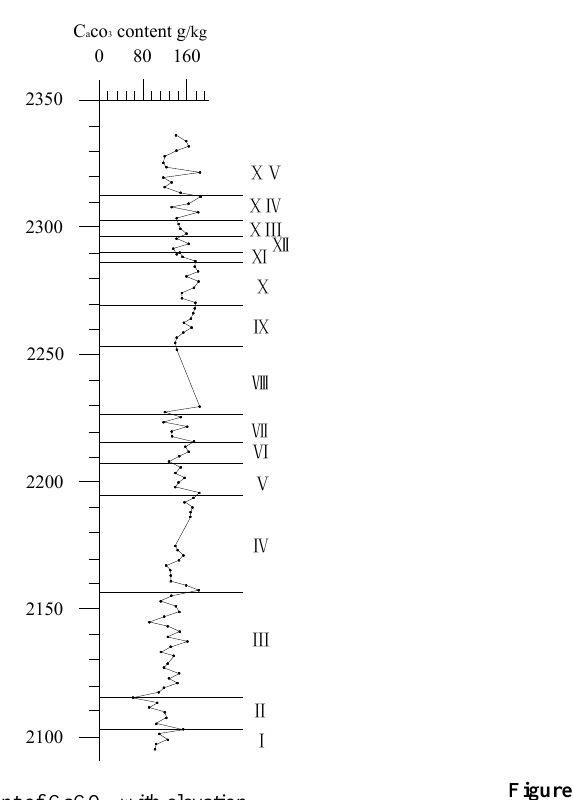
along the elevation Figure 8. Content of CaCO 3 3 with elevation.